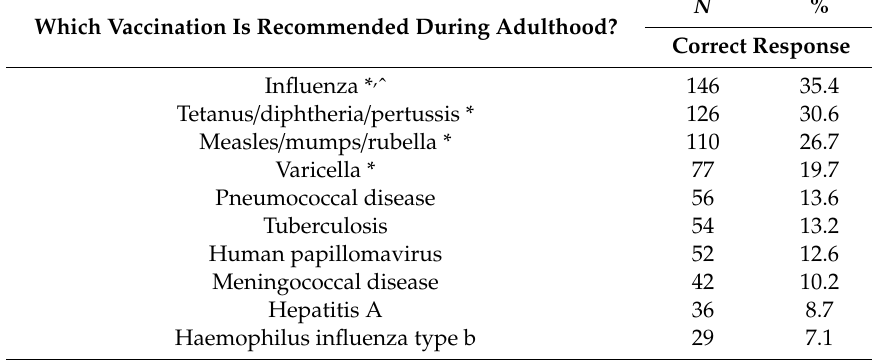
Table 2. Participant’s knowledge about the recommended vaccinations.